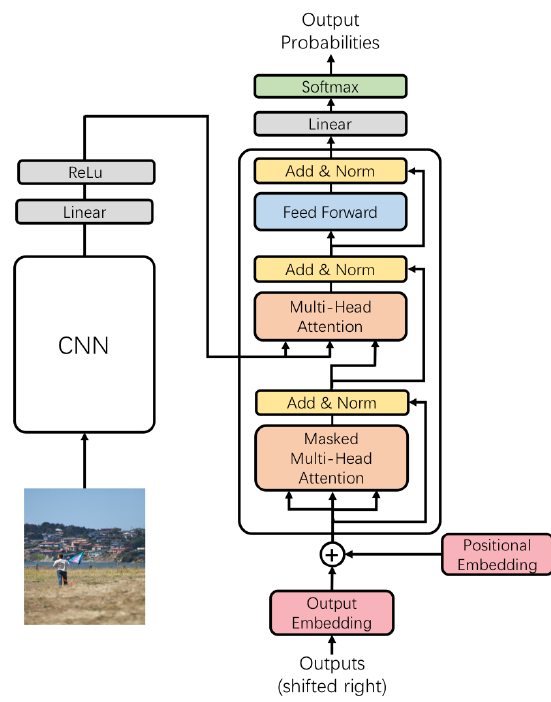
Figure 1. The framework of the proposed model. As shown in the figure, the model contains two components, the encoder and the decoder. The encoder is the CNN and the decoder is the Transformer. The CNN can use different state-of-the-art image classification models, such as ResNet and ResNext. The decoder is the Transformer with stacked Multi-Attention and Feed Forward Layer. In this figure, we only show one Transformer decoder layer. In practice, the Transformer decoder model contains N identical decoder